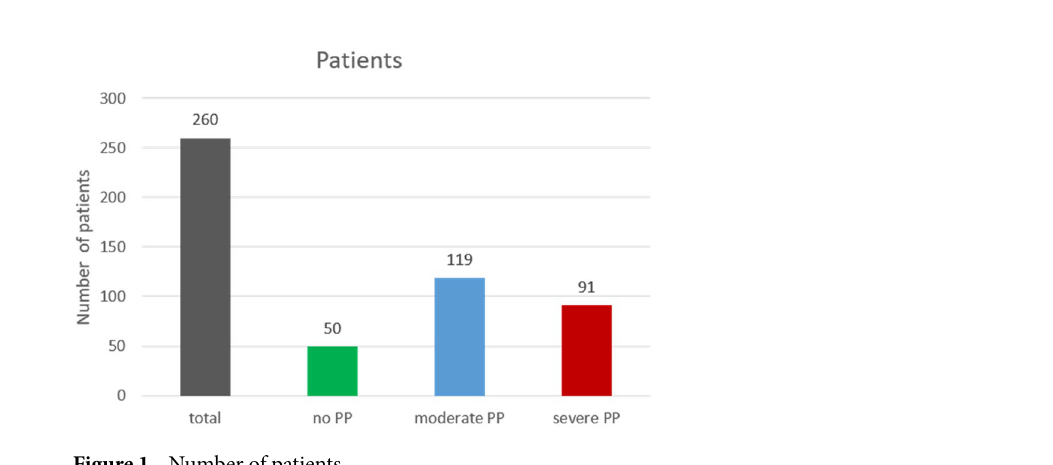
Figure 1. Number of